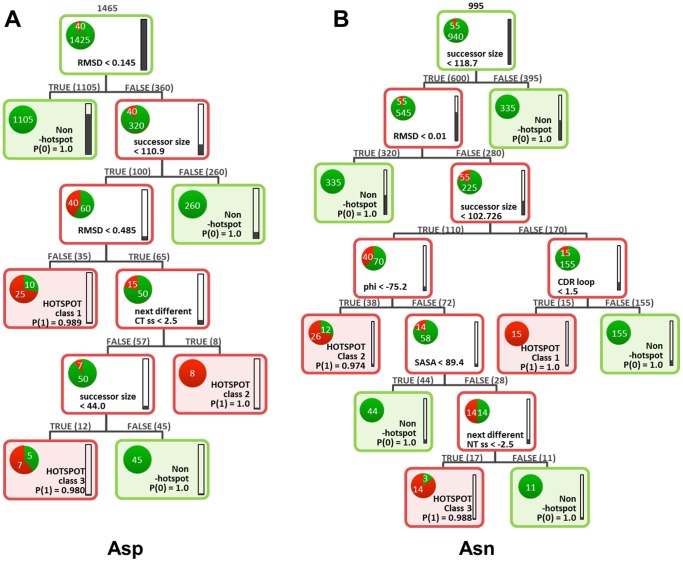
Final Aspartate (A) and asparagine (B) decision trees.The outline of nodes and leaves is colored by the weighted majority of the class that is present (red: hotspots, green: non-hotspots). Filling levels of the bars on the right hand side of each node/leaf refer to the fraction of the data set. The fraction of each class at a node/leaf is shown by the colored fraction of the circle. The number of members of each node/leaf is indicated above.